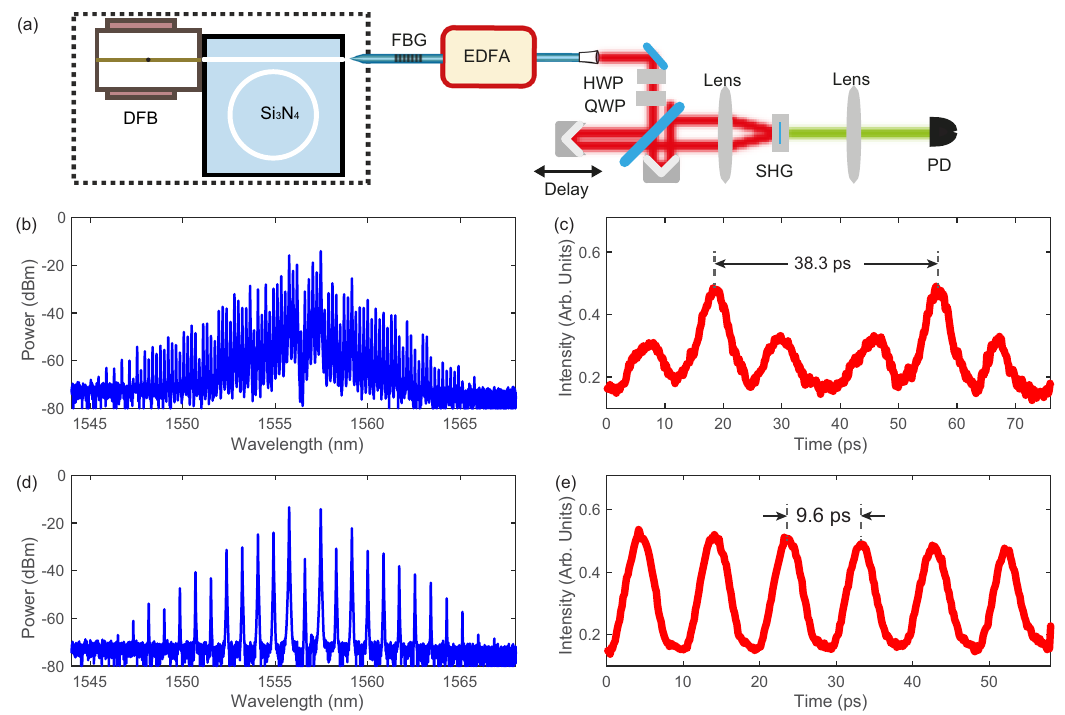
Fig. 4 Second-order non-collinear autocorrelation measurement of platicon states. a Experimental setup for the autocorrelation measurement. EDFA: erbium-doped fi ber amplifer. HWP: half-wave-plate. QWP: quarter-wave-plate. SHG: second harmonic generation. FBG: fi ber Bragg grating notch fi lter. b , d Microcomb optical spectra of a dual-platicon state and a 4-platicon perfect crystal state, respectively, with pump line suppressed by an FBG fi lter. Since the dual-platicon state is not a perfect crystal state, its comb line spacing is of a single FSR. For the 4-platicon perfect crystal state, the comb line spacing is 4 FSR. c , e The corresponding intensity autocorrelation traces of the two platicon